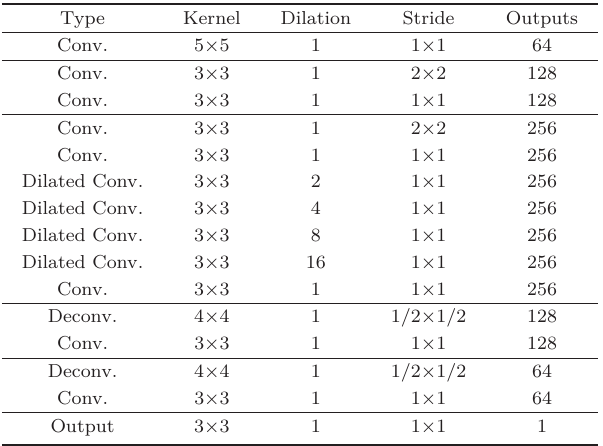
Table 2 Generator architecture. After each convolutional layer, except the last, there is a rectified linear unit (ReLU) layer. The